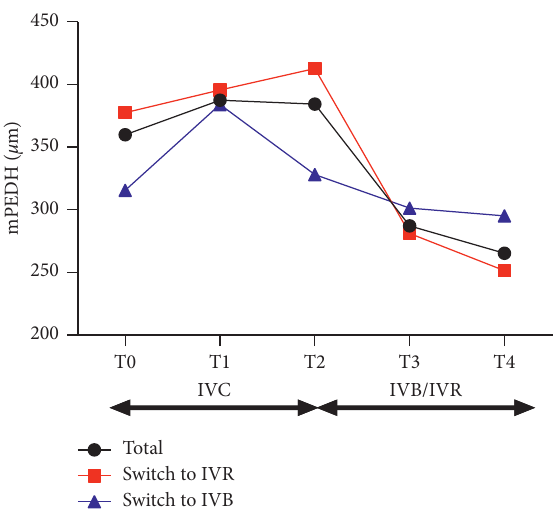
Figure 2: Changes of mean CMT in eyes with persistent nAMD. The mean CMTdecreased significantly from T0 to T1 ( p � 0 . 0149) followed by no further regression. But after switching to IVR or IVB, it decreased significantly from 294.9 ± 121.8 μ m at T2 to 230.9 ± 107.0 μ m at T3 and 220.4 ± 105.4 μ m at T4. No significant difference was found between IVR and IVB subgroups for the mean decrease of CMT from T2 to T3 ( p � 0 . 53) and T4 ( p � 0 . 23). CMT, central macular thickness; IVC, intravitreal injections of conbercept; IVB, intravitreal injection of bev- acizumab; IVR, intravitreal injection of ranibizumab; T0, baseline visit; T1, 1 month after the first ICV; T2, 1 month after 3 monthly IVC; T3, 1 month after the first IVR or IVB; T4, 1 month after the last IVR or